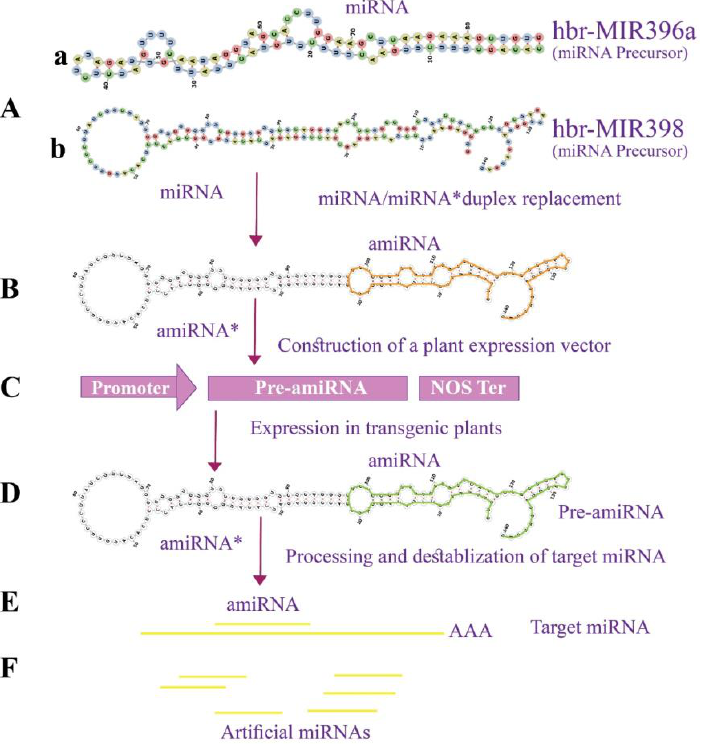
Figure 8. Schematic representation of amiRNA-mediated gene-silencing strategy designed to develop transgenic rubber tree cultivars. The candidate amiRNAs are the consensus hbr-MIR396a and hbr-MIR398 precursors, and are designed after miRNA/miRNA duplex replacement. More pre-amiRNAs are processed to develop a mature amiRNA/amiRNA*duplexes.